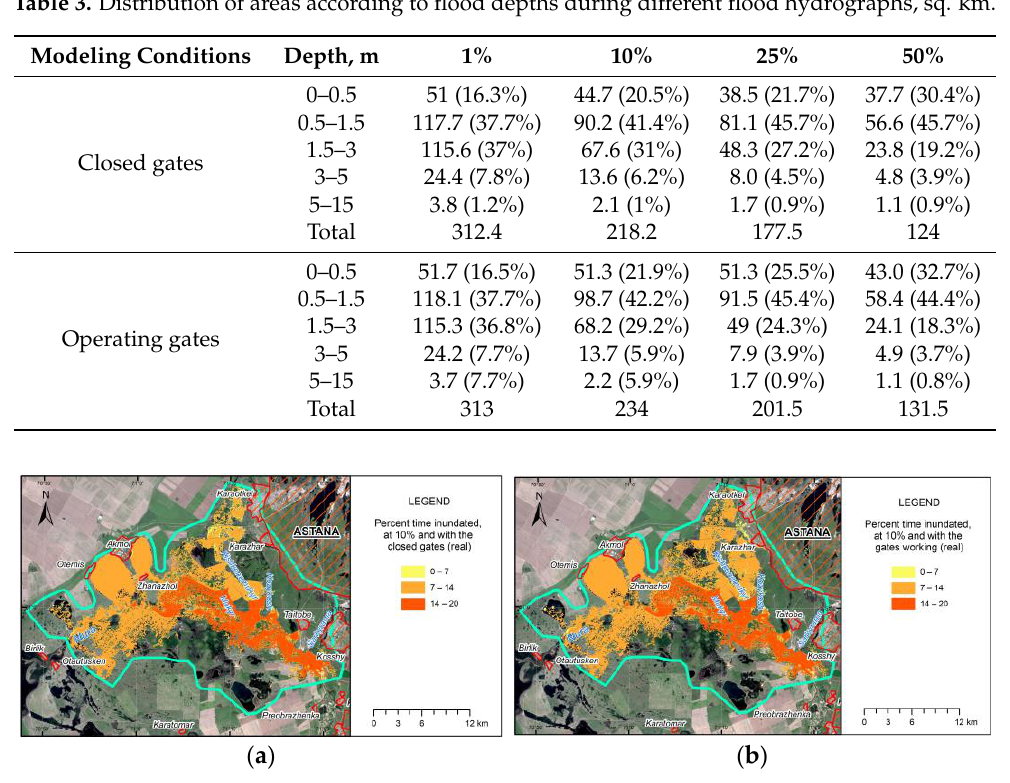
Figure 12. Distribution of flood duration during 10% exceedance probability flood hydrograph with closed gates ( a ) and operating gates ( b ). Table 4. Flooded areas with different inundation duration, sq. km .